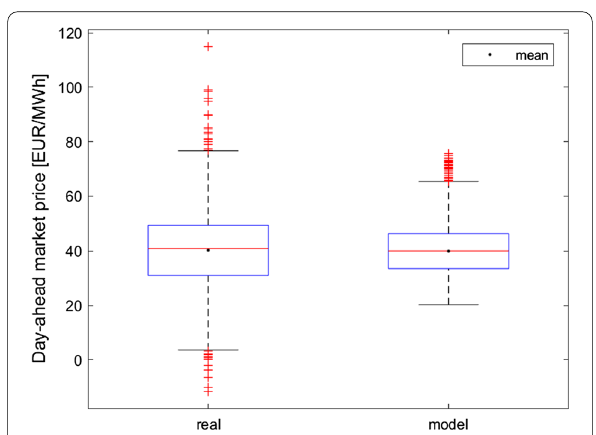
Fig. 8 Comparing observed (“real”) and simulated